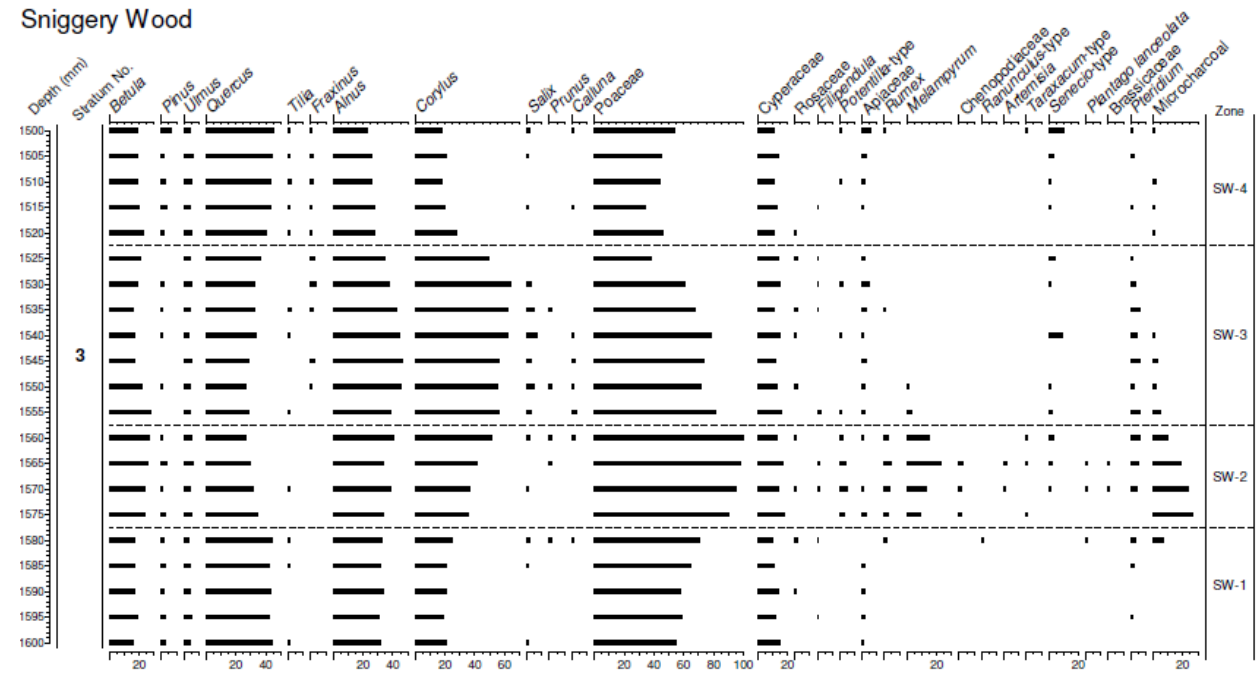
Figure 2. Selected taxa pollen diagram through a Mesolithic age disturbance phase at Sniggery Wood, Merseyside. Frequencies are calculated as percentages of total tree pollen, which comprises Betula to Alnus on the diagram.